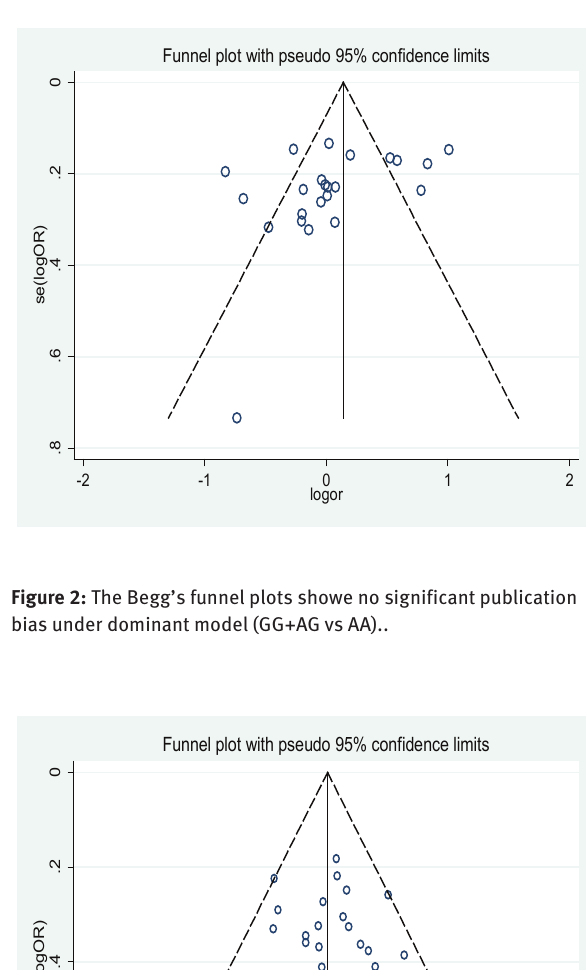
Funnel plot with pseudo 95% confidence